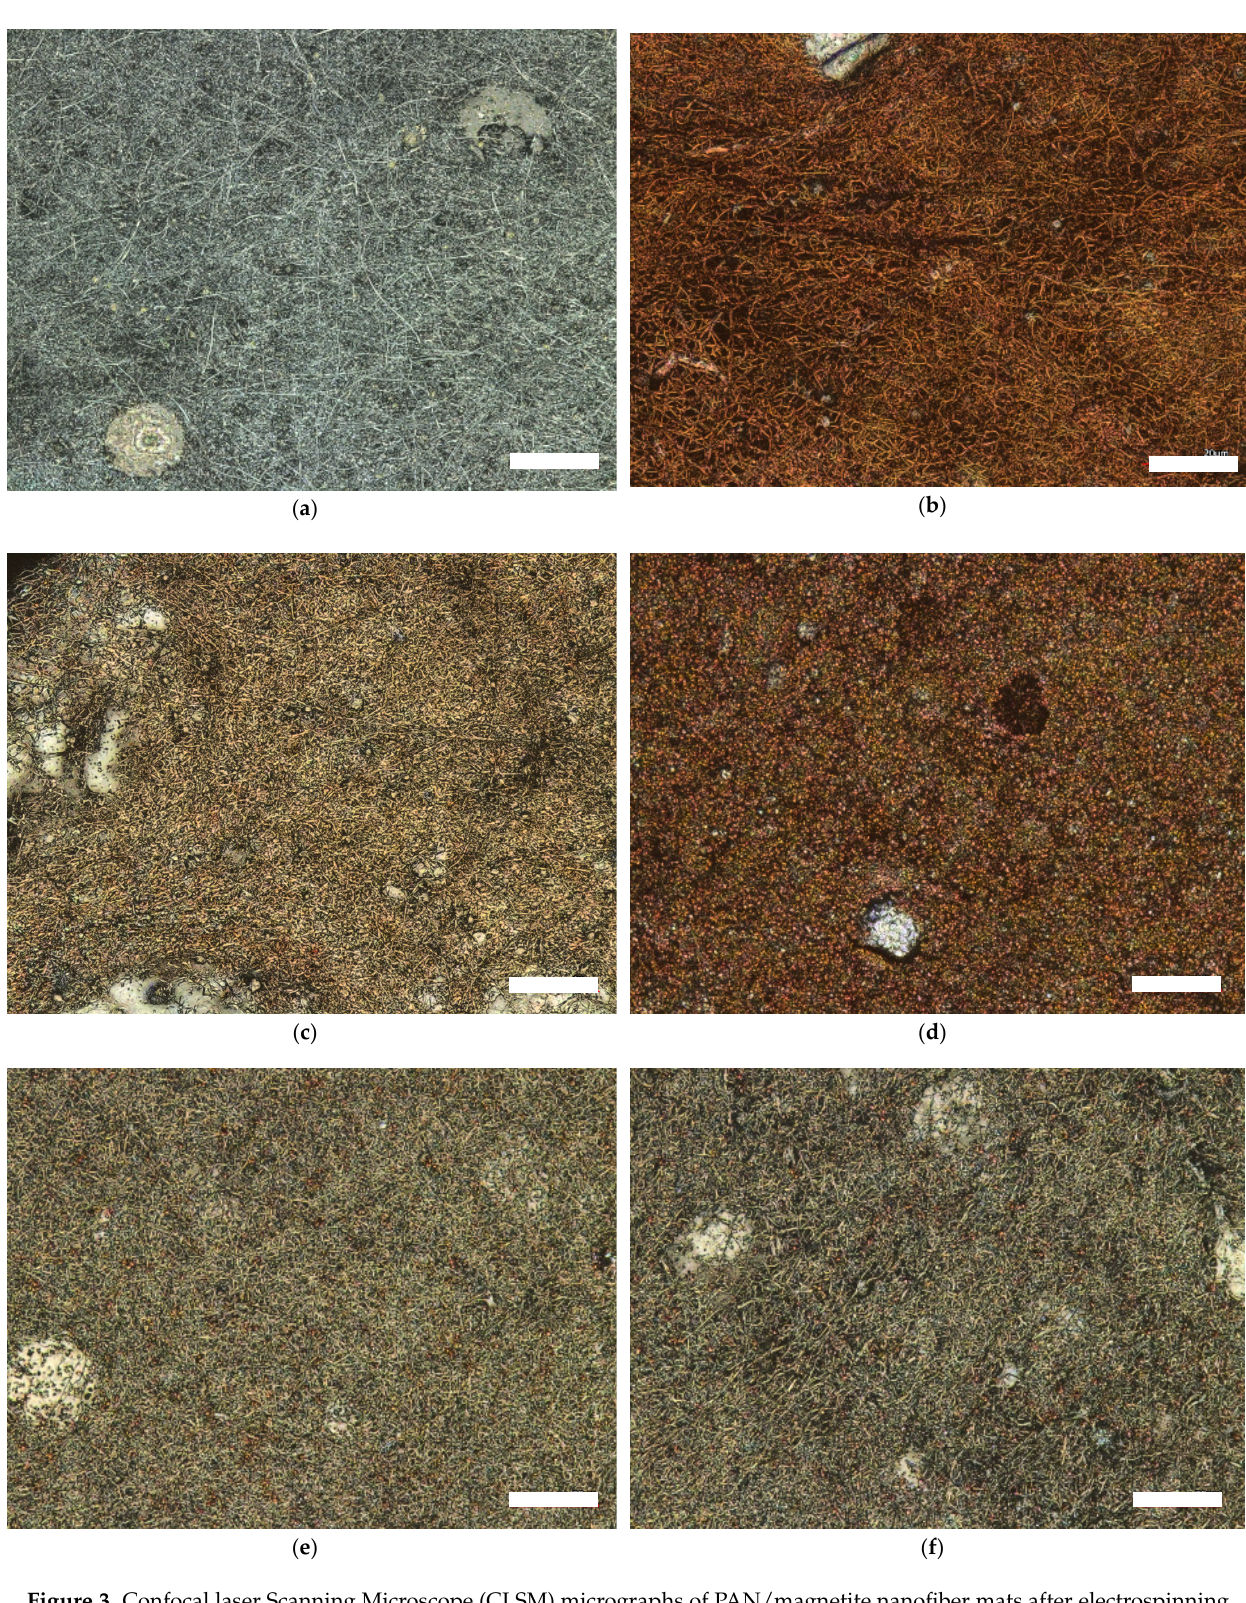
Figure 3. Confocal laser Scanning Microscope (CLSM) micrographs of PAN/magnetite nanofiber mats after electrospinning ( a ), after stabilization at 280 °C ( b ), after thermal treatment at 500 °C ( c ), at 600 °C ( d ), at 800 °C ( e ), and at 1000 °C ( f ). The scale bars indicate 20 μ m.